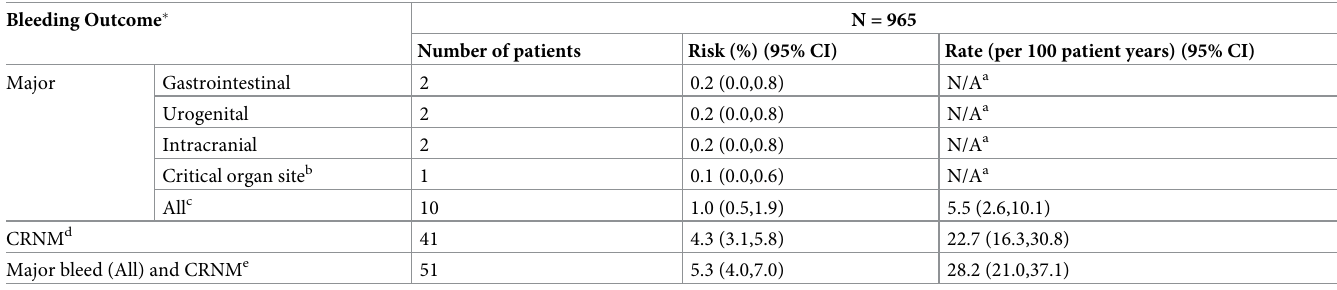
Table 2. Incidence risk and rates of major of CRNM